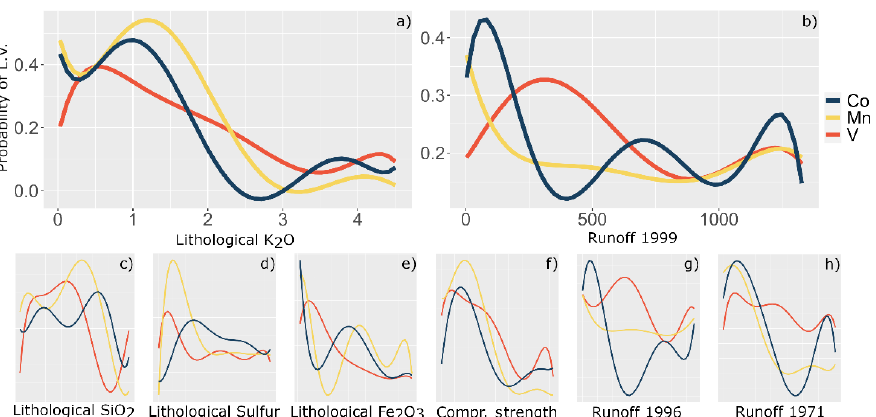
Figure 5. PDP plots for group C2. The x -axis represents a MIV, the y -axis represents the associated probability of a L.V. (lower value) classification. Each line represents the relationship for a single metal. The plots show: ( a ) Lithological K 2 O (mean accumulated percentage of lithological potassium oxide content), ( b ) Runoff 1999 (mean annual runoff in 1999), ( c ) Lithological SiO 2 (the estimated accumulated lithological silicon dioxide content), ( d ) Lithological sulfur (mean accumulated per- centage of lithological sulfur (S) content), ( e ) Lithological Fe 2 O 3 (mean accumulated percentage of lithological ferric oxide content), ( f ) Compressive strength (mean accumulated lithological compres- sive strength), ( g ) Runoff 1996 and ( h ) Runoff 1971. Lines are displayed after smoothing with a pol- ynomial regression for display purposes.